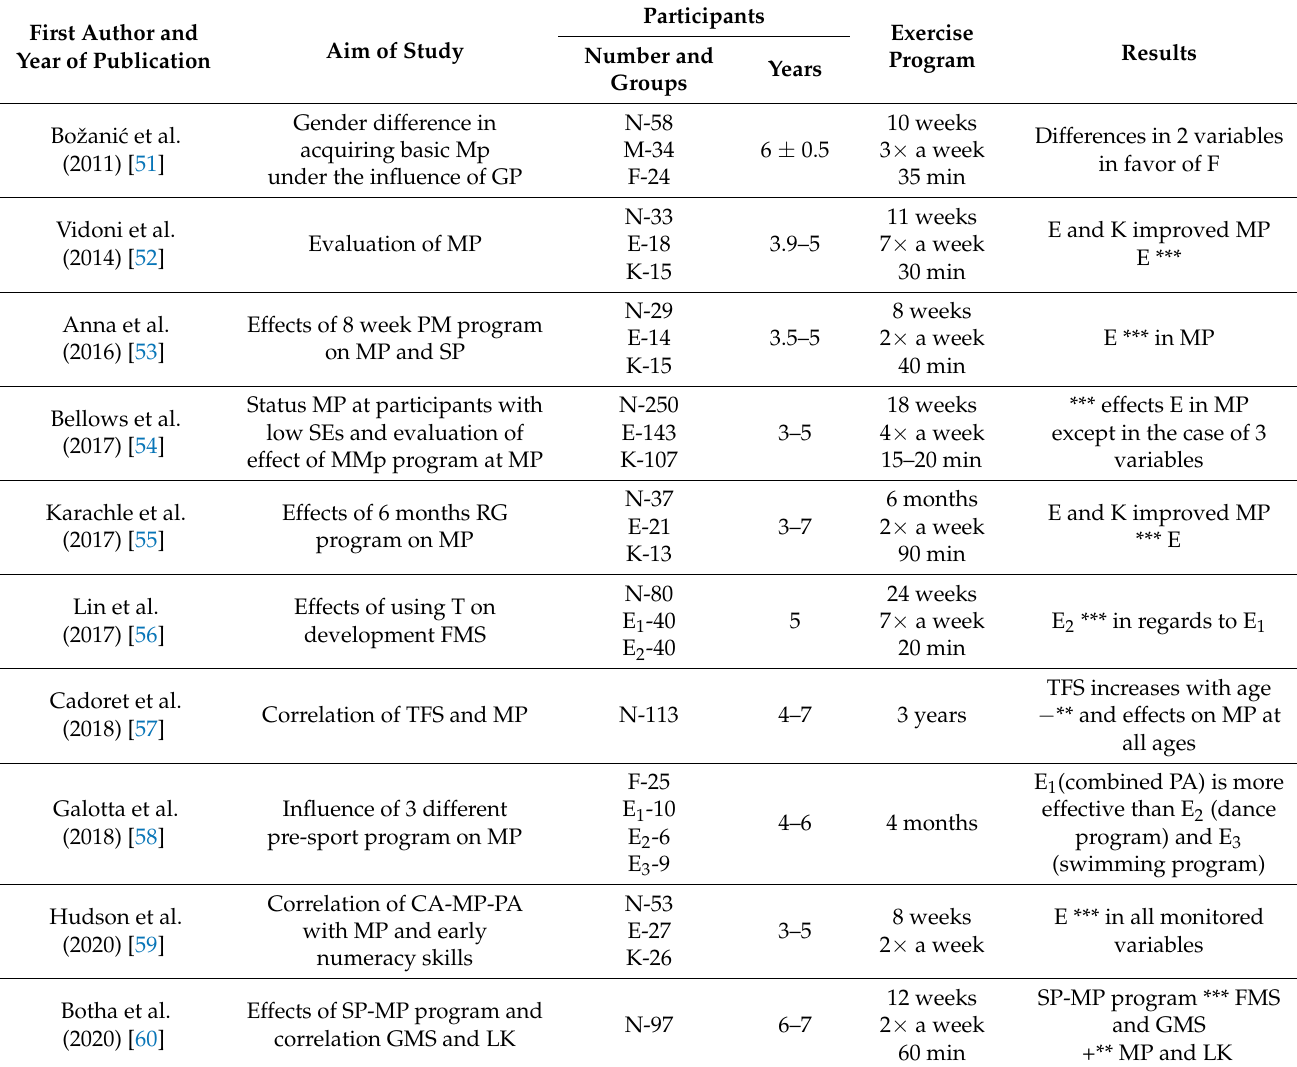
Table 4. Effects of different programs on short form